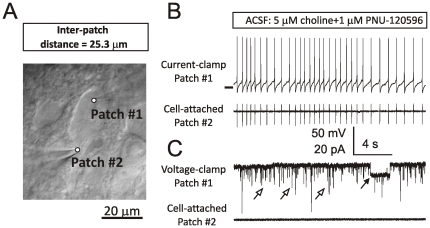
Reliability of physiological responses.A large hypothalamic TM neuron with two attached patch-clamp electrodes and an inter-patch distance of 25.3 µm (A). Examples of patch-clamp recordings obtained from the neuron shown in (A) under two experimental conditions: (B) Electrode #1 is in current-clamp (B, top trace), while Electrode #2 is cell-attached (B, bottom trace); and (C) Electrode #1 is in voltage-clamp at −70 mV (C, top trace), while Electrode #2 is cell-attached (C, bottom trace). Open arrows in (C) point at spontaneous synaptic currents. Closed arrow points at a step-like deviation corresponding to an individual α7 nAChR-mediated ion channel opening. ACSF always contained 5 µM choline plus 1 µM PNU-120596. A horizontal bar in (B) top trace indicates the membrane voltage of −50 mV. Currents were not injected in current-clamp.